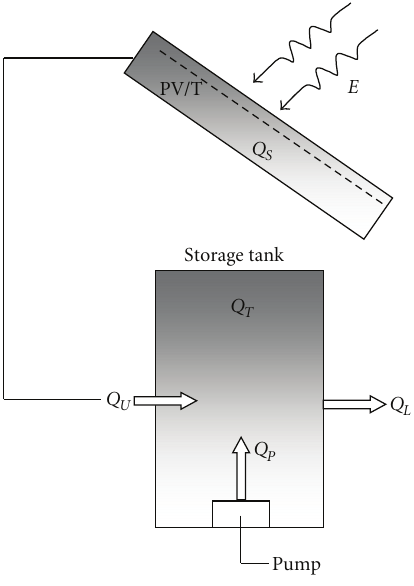
Figure 3: The energy flow in the system.